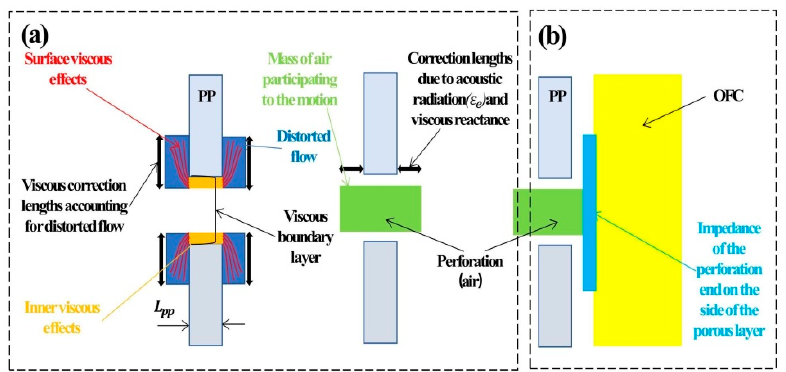
Figure 2. Physical phenomena involved in the composite sound-absorber structure: ( a ) the PP; ( b ) the composite sound-absorber structure.